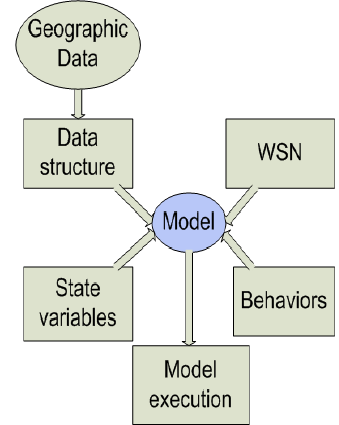
Figure 18. Workflo formodelingphysicaland WSN